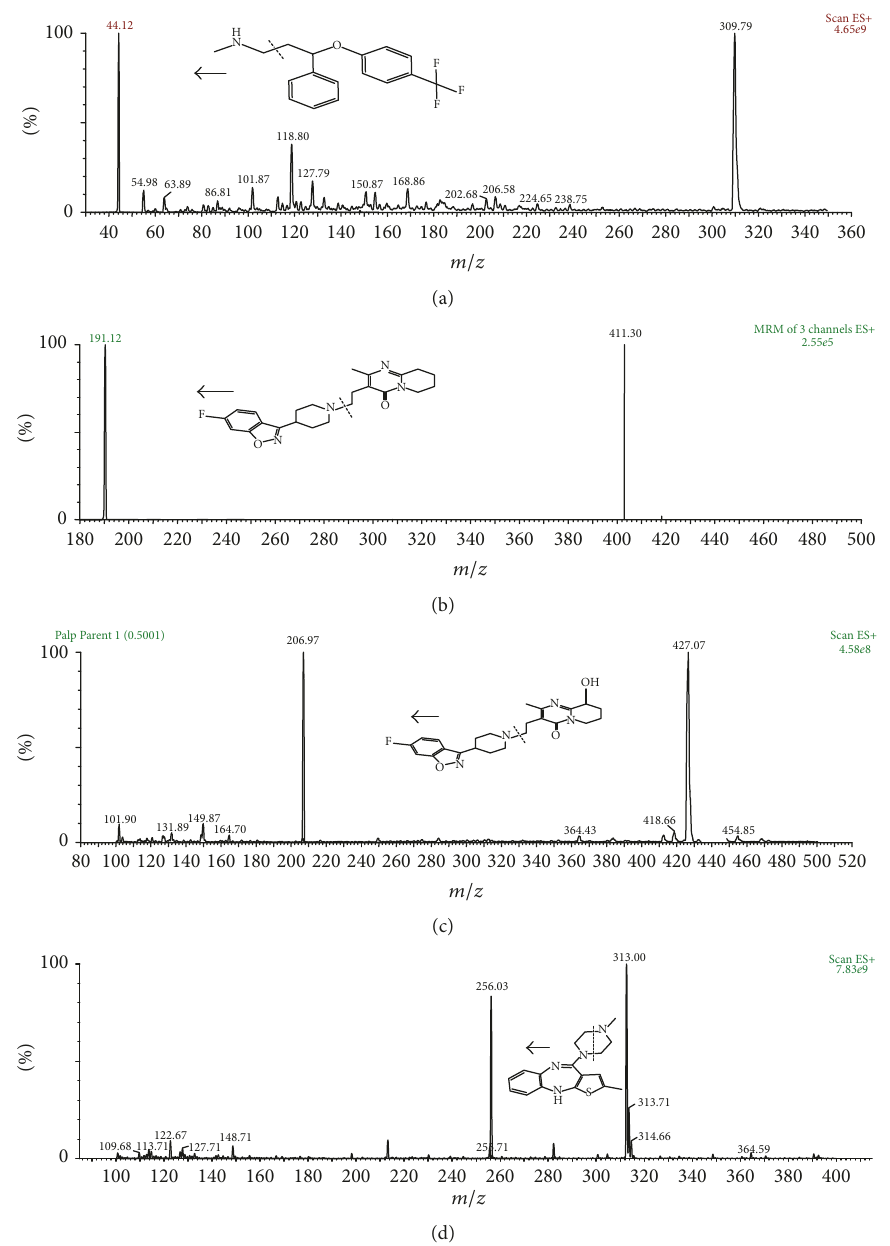
Figure 2: Full scan positive ion mass spectra and the proposed fragmentation of (a) FLX, (b) RIS, (c) 9-OH-RIS, and (d) OLA (IS).